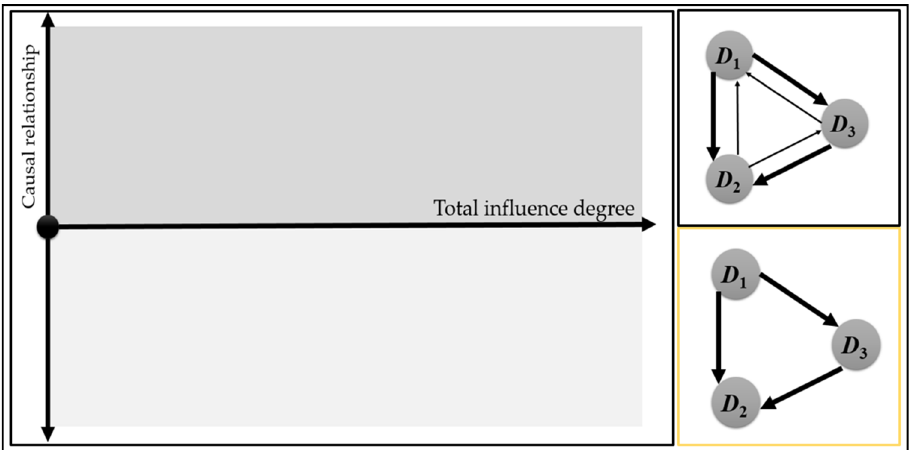
Figure 3. Constructing the INRM.